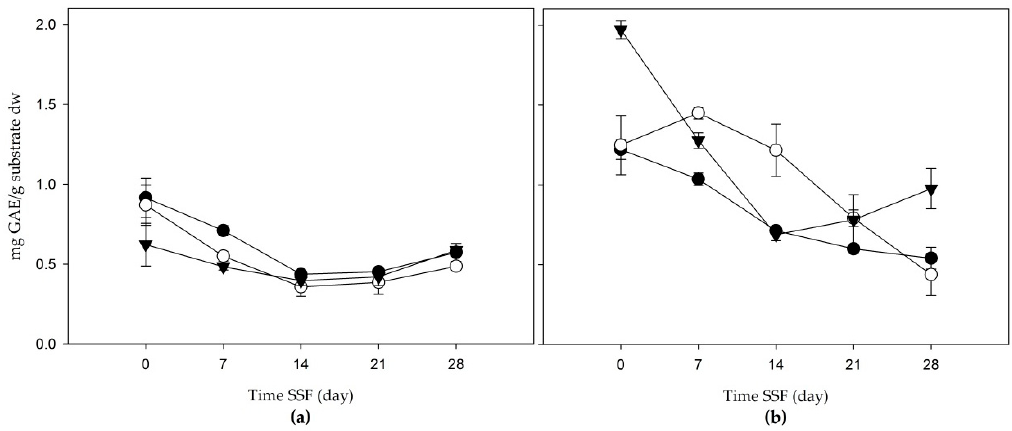
Figure 1. Total phenolic compounds (mg gallic acid equivalent per g substrate on dry weight (mg GAE/g substrate dw)) of the solid-state fermentation of agroindustrial residues: ( a ) Apple bagasse; ( b ) Agave mezcalero bagasse. Acetone and water (80:20 v/v ( )); methanol extract ( ); aqueous extract ( ). Time SSF = time solid-state fermentation. Values are the mean ± standard deviation.